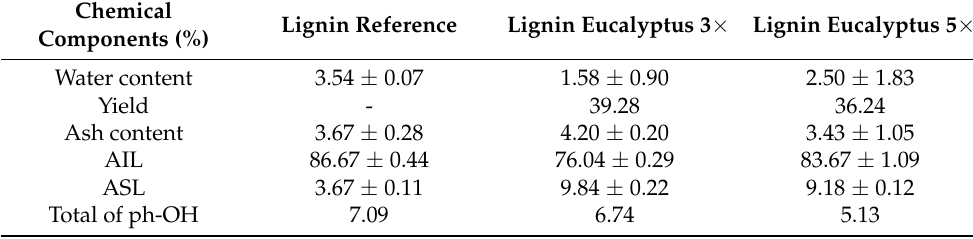
Table 1. Chemical components of Eucalyptus lignin after 3 and 5 washing